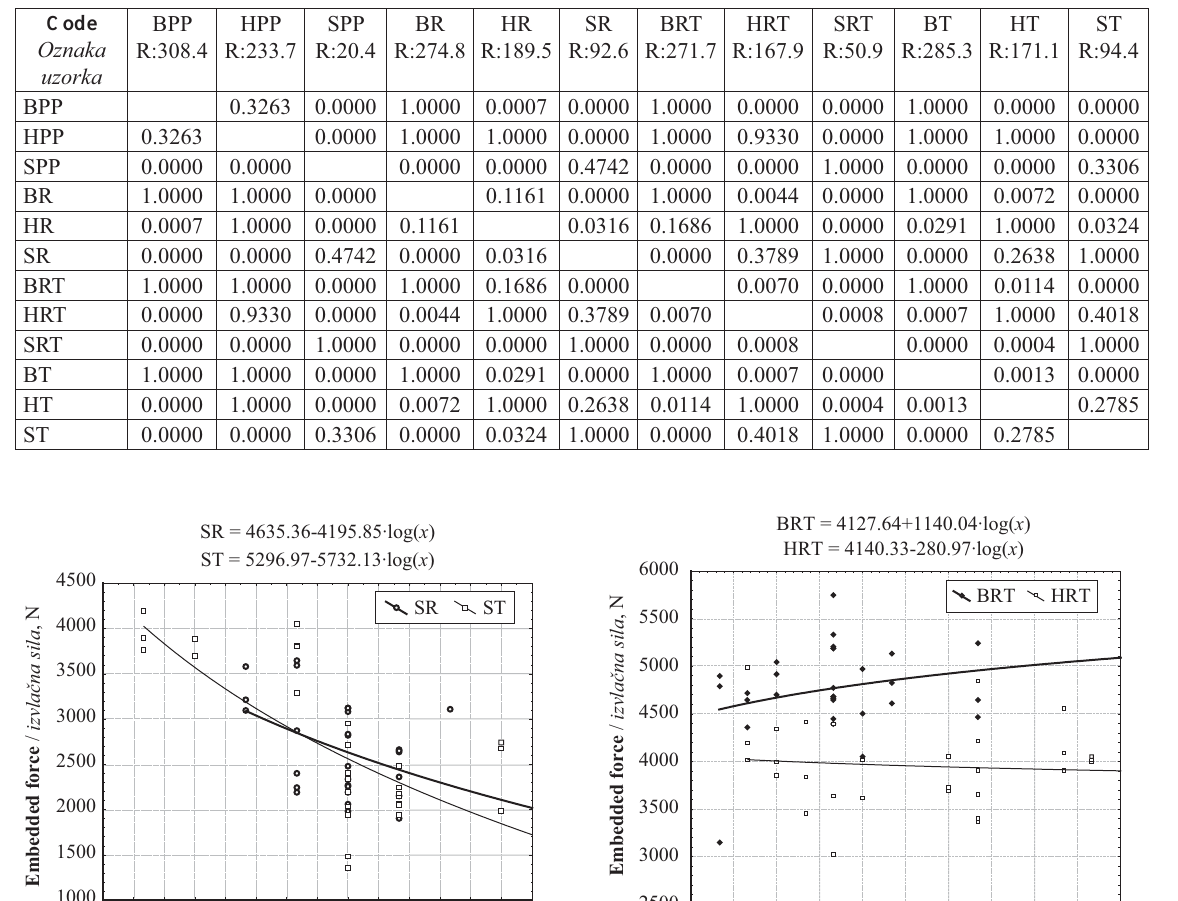
Table 3 Multiple comparison rankings (Kruskal-Wallis test: H (11, N = 359) = 297.9809 p = 0.000) Code Oznaka